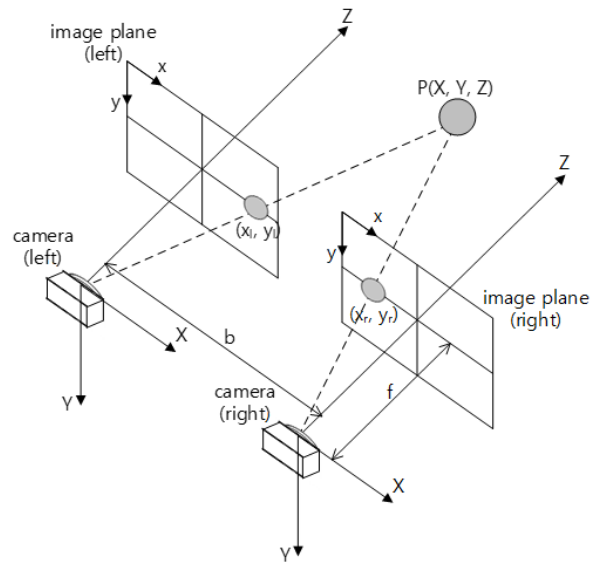
Figure 5. Parallel stereo camera model.